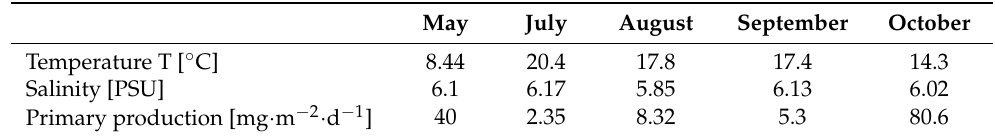
Figure 1. The area of the Baltic Sea where the seawater samples were taken. Table 1. Parameters of seawater sampled from Gdynia station, located in the coastal waters of the Gulf of Gdansk in the Southern Baltic Sea in Poland [39].